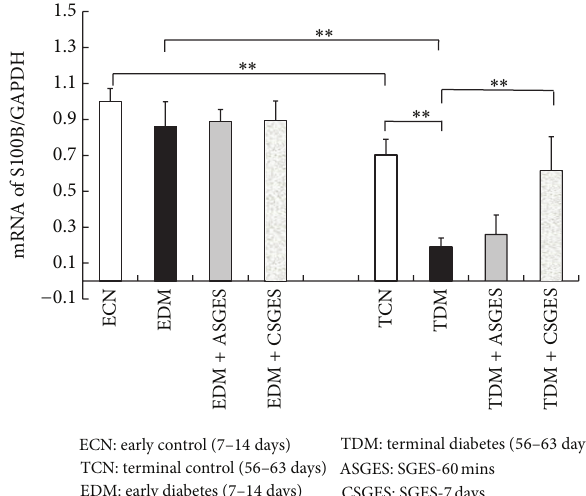
Figure 6: mRNA values of S100B in the enteric plexus of stomach. The mRNA expression of S100B was decreased with the course of diabetes, especially in TDM. But there were no differences between ECN and EDM. Furthermore, both mRNA expressions of S100B in TDM and TCN were significantly decreased compared with the age-matched early group. The expression of S100B mRNA in TDM increased both after ASGES and CSGES compared with TDM; statistical analysis showed significant differences between CSGES group and TDM group, but no statistical differences were observed between ASGES and TDM. Data are presented as means ± SD. ∗ 𝑃 < 0.05 , ∗∗ 𝑃 < 0.01